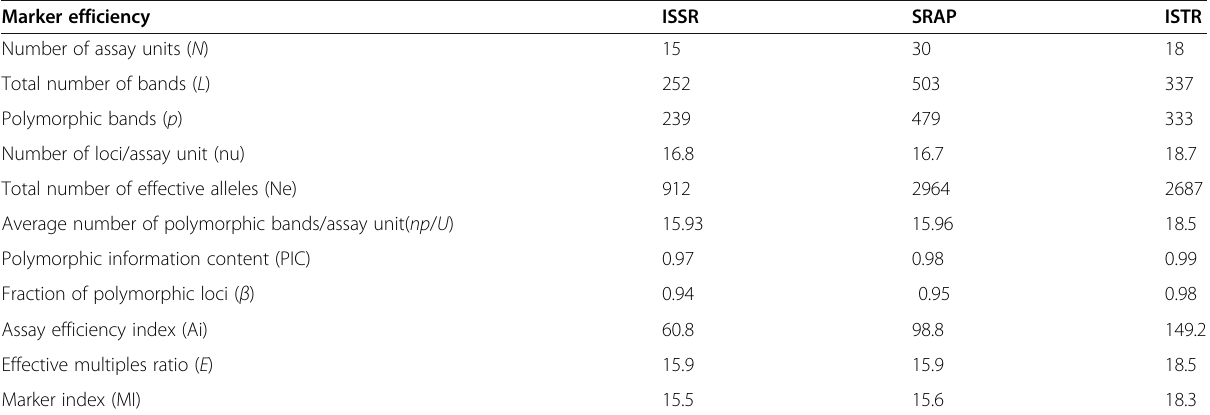
Table 3 Summary statistics of the information obtained with and discriminating capacity of ISSR, SRAP, and ISTR markers within twelve Capparaceae and Cleomaceae species